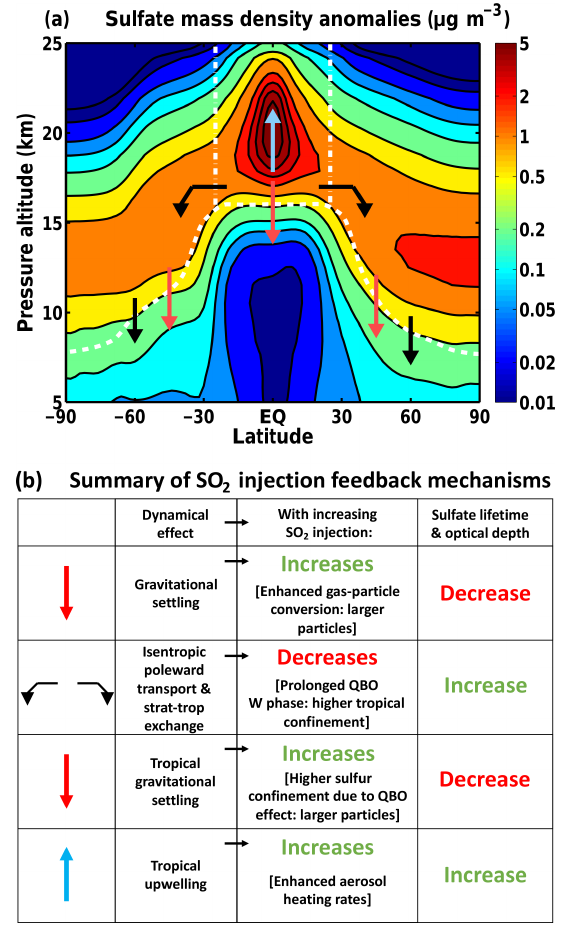
Figure 2. (a) Annually and zonally averaged sulfate mass den- sity anomalies (µgm − 3 ), due to a geoengineering injection of 5TgSO 2 yr − 1 , with respect to a RCP4.5 background atmosphere. The aerosol mass density distribution is calculated in the Goddard Earth Observing System Chemistry Climate Model (GEOSCCM), with SG treated as described in Pitari et al. (2014). Arrows super- imposed to the aerosol distribution indicate the main transport path- ways of the aerosol particles, as explained in (b) . The white dashed line shows the mean tropopause; the dash-dotted white lines high- light the stratospheric tropical region. The sensitivity of each dy- namical effect to the SO 2 injection is highlighted in (b) , along with the physical mechanisms driving the perturbation and the net effect on sulfate lifetime and optical